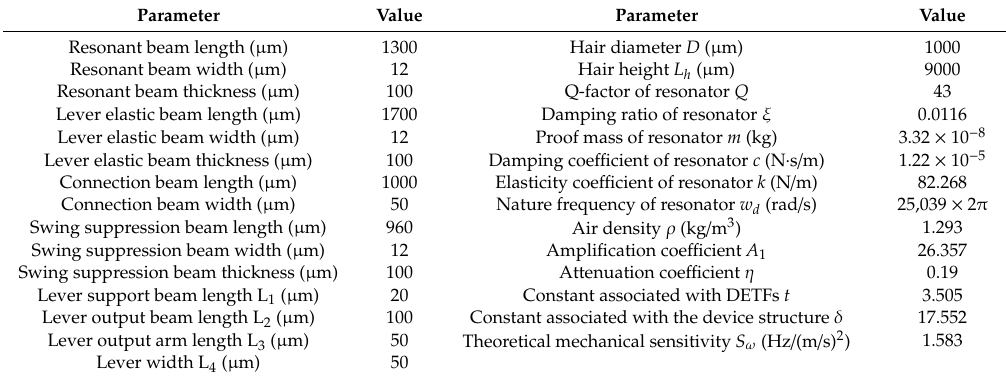
Figure 1. Schematic of the bionic hair flow. ( A ) The whole structure. ( B ) The double-ended tuning fork. ( C ) The lever elastic beam. ( D ) The resonator. ( E ) The silicon micro signal transducer. Table 1. Structure parameters.